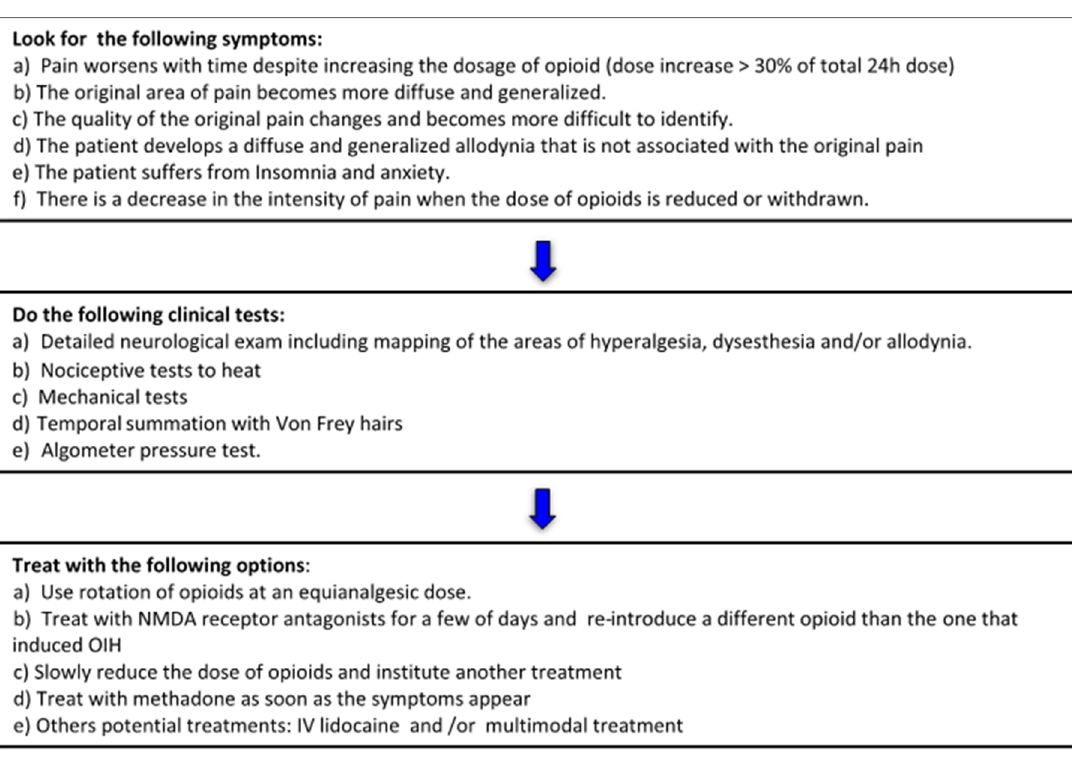
Figure 1. Algorithm 1.